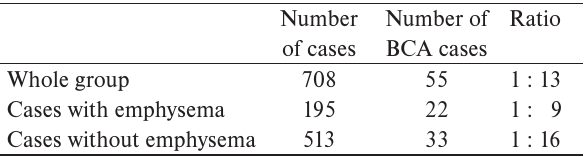
Table 3. Frequency of lung cancer found in the group of the deceased with and without emphysema.